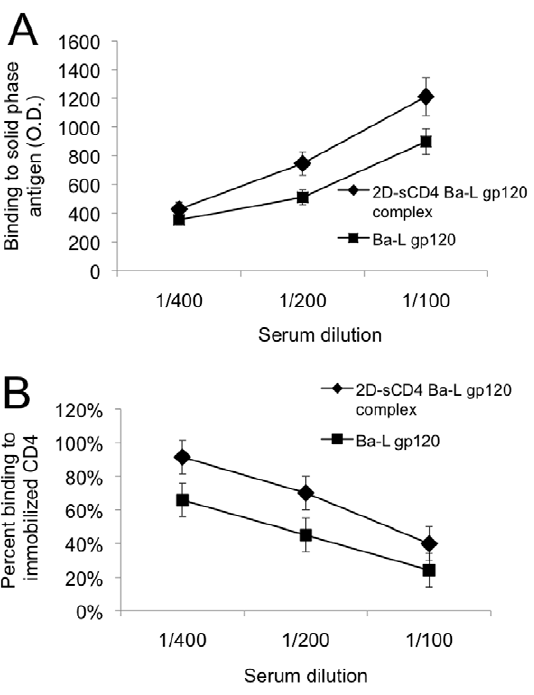
Figure 2. Inhibition of HIV-1 Env-mediated fusion by sera from mice immunized with CD4-complexed HIV-1 Env. era from mice immunized with autologous NIH 3T3 cells expressing HIV-1 Ba-L Env in complex or not with soluble CD4 were tested for inhibition of HIV-1 Env-mediated fusion using PM-1 ( A ) of Sup-T1 ( B ) cells chronically infected with HIV-1 Ba-L or IIIB, respectively, as effector cells. NIH 3T3 cells expressing human CD4 and the appropriate coreceptor (CXCR4 or CCR5) were used as target cells. Sera from 4 immunized mice were pooled. Fusion inhibition is expressed as percent of the positive control, i.e., the amount of fusion measured when the fusion partners were reacted in the presence of pre-immune sera.